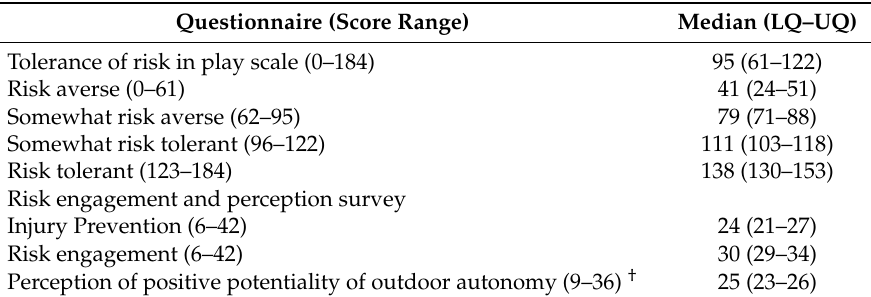
Table 3. Survey summary statistics (n =